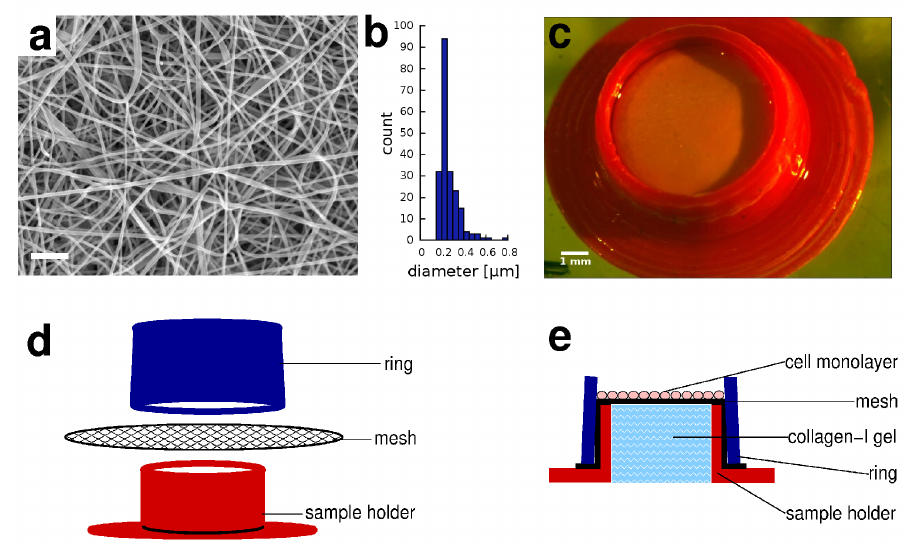
Figure 1. Skin equivalent sample holder device. ( a ) Scanning electron microscopic image of the electrospun PCL nanomesh consisting of filaments with sub-micron diameter. Scale bar: 3 µ m. ( b ) Filament diameter distribution of the electrospun nanomesh, obtained from n = 4 independent samples. ( c ) The assembled sample holder device, scale bar represents 1 mm. ( d ) Schematic drawing depicting the parts of the device. ( e ) Schematic cross section of the assembled sample holder device. The electrospun nanomesh serves as the substrate of the cells and is stretched across the sample holder containing collagen-I gel. The mesh is hold in place by a tightly fitting cone shaped